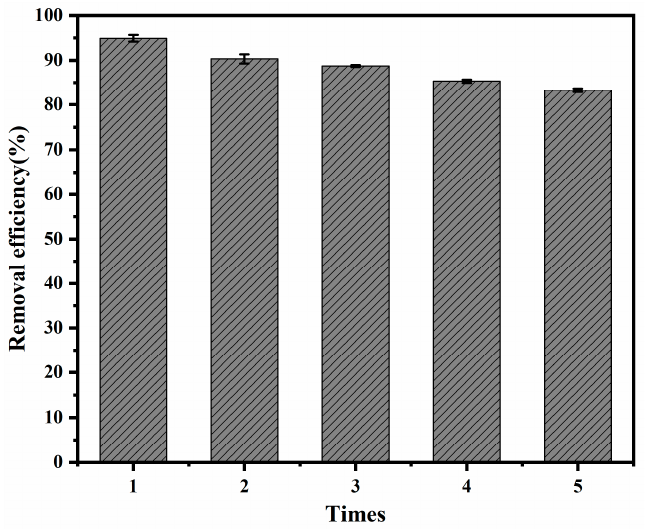
Figure 8. Removal efficiency of interfering molecules. Other conditions: 10 mg sorbent, 10 mL sample solution, shaking time 1 h, temperature 25 °C.